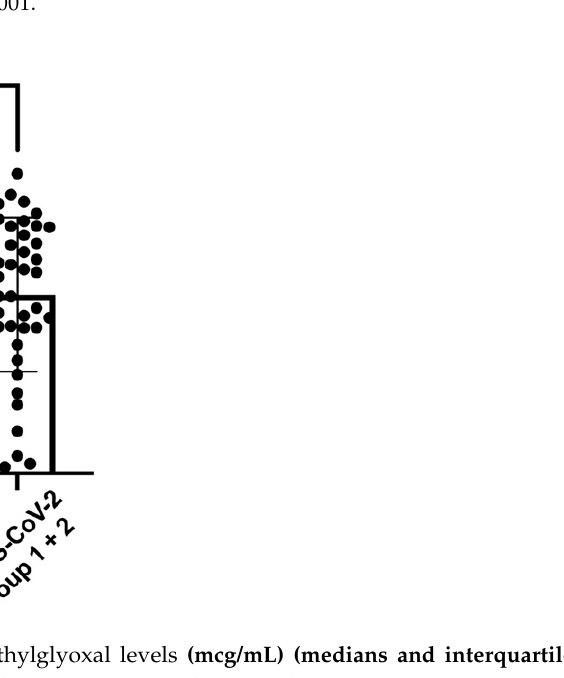
Figure 2. Scatterplot of methylglyoxal levels (mcg/mL) (medians and interquartile SARS-CoV-2 groups 1 and 2 (0.39; IQR 0.29–0.50) versus the SARS-CoV-2-negative controls (0.28; ranges) of SARS-CoV-2 groups 1 and 2 (0.39; IQR 0.29–0.50) versus the SARS-CoV-2- IQR 0.20–0.39). ** p -value < negative controls (0.28; IQR 0.20–0.39). ** p -value < 0.003.